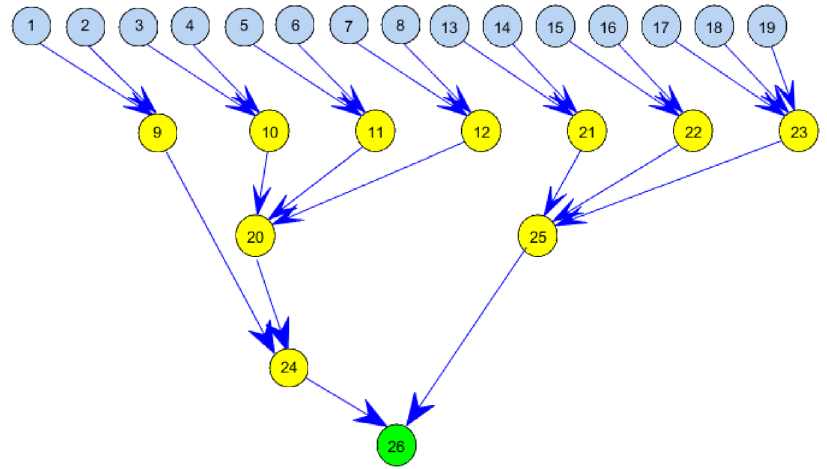
Fig. 7. Bayesian network simulation diagram of electromechanical braking system. Table 4. Posterior probability of each root node. Root node Posteriori probability